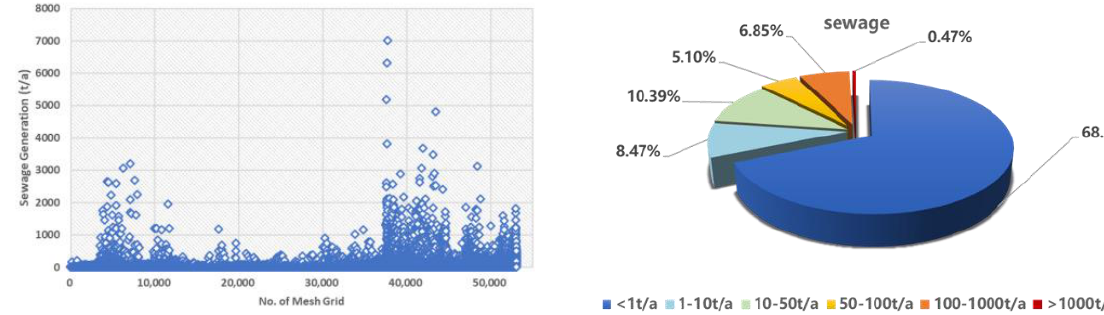
Figure 7. Classification diagram of sewage generation.